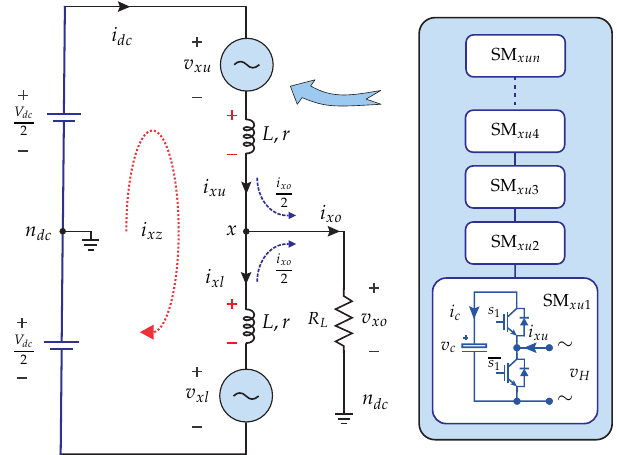
Figure 2. Single-phase equivalent circuit of MMC